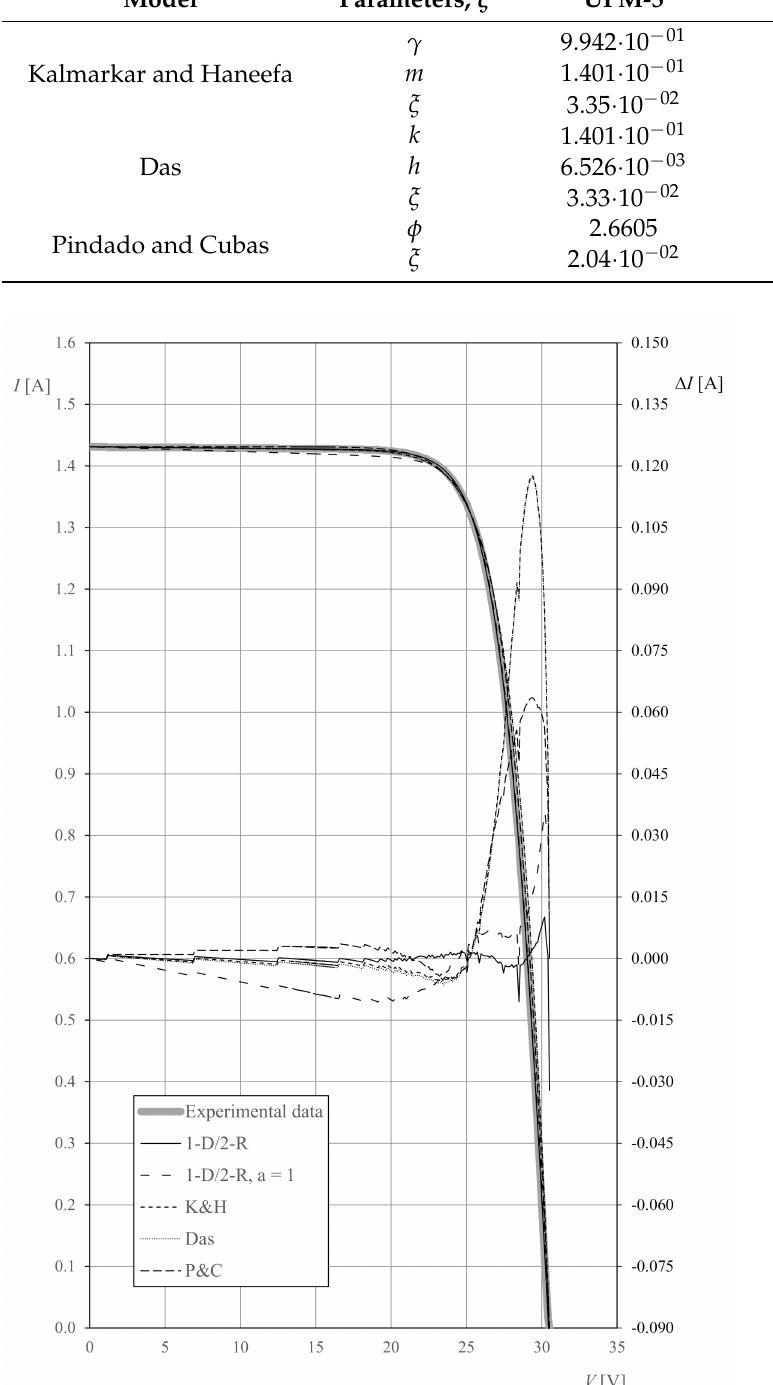
Figure 11. I-V experimental curve (left axis) for the UPM-5 solar panel. Curves for the 1-D/2-R equiv- alent circuit model (obtained using two procedures: best fit to the parameters obtained numerically and analytical extraction) and the explicit methods proposed by Kalmarkar and Haneefa, Das and Pindado and Cubas are shown. The differences in the current compared to the experimental data are indicated on the right